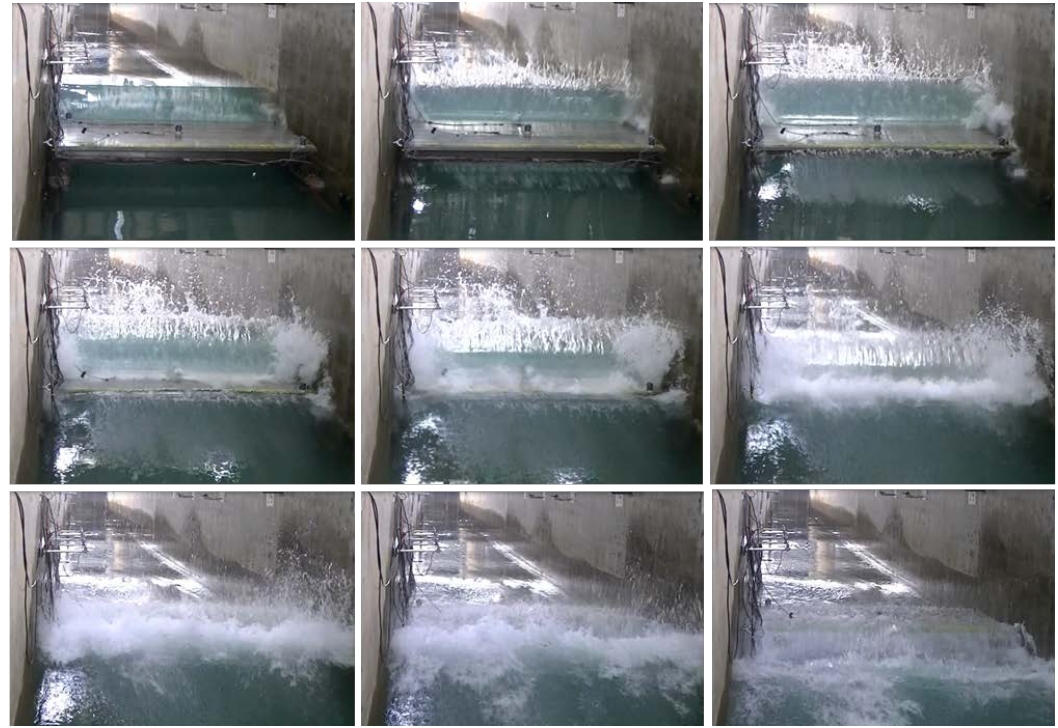
Figure 18. Snapshots during the wave impact and inundation of the bridge deck.